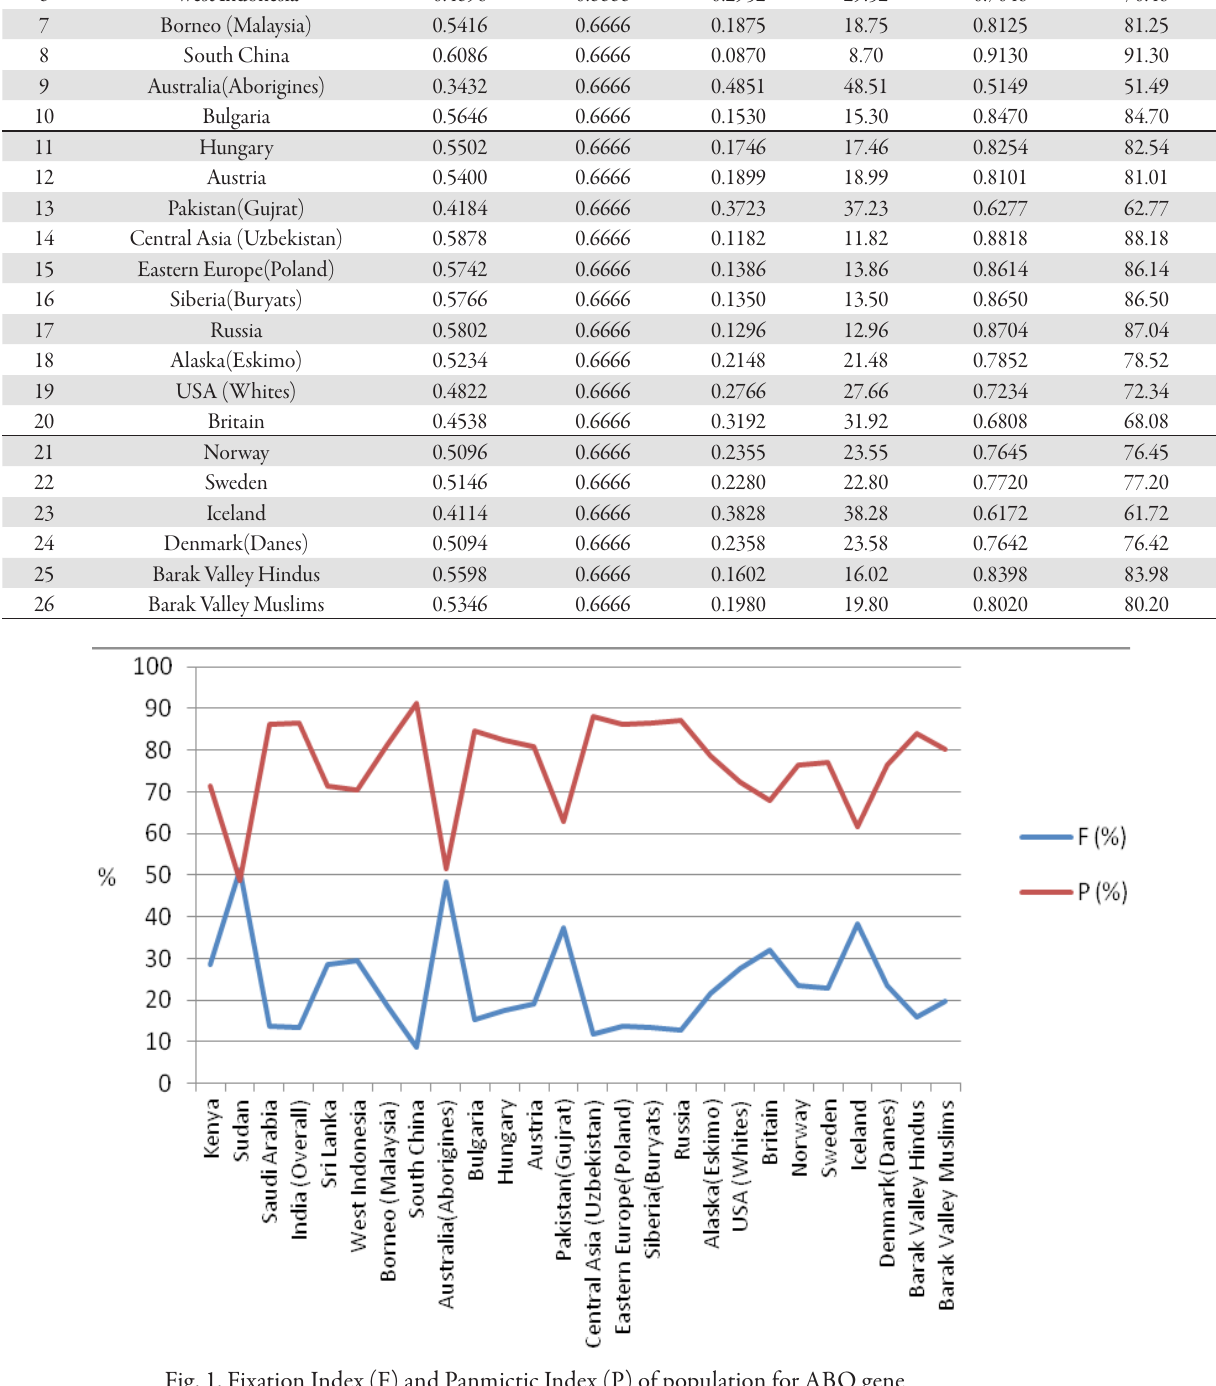
Fig. 1. Fixation Index (F) and Panmictic Index (P) of population for ABO